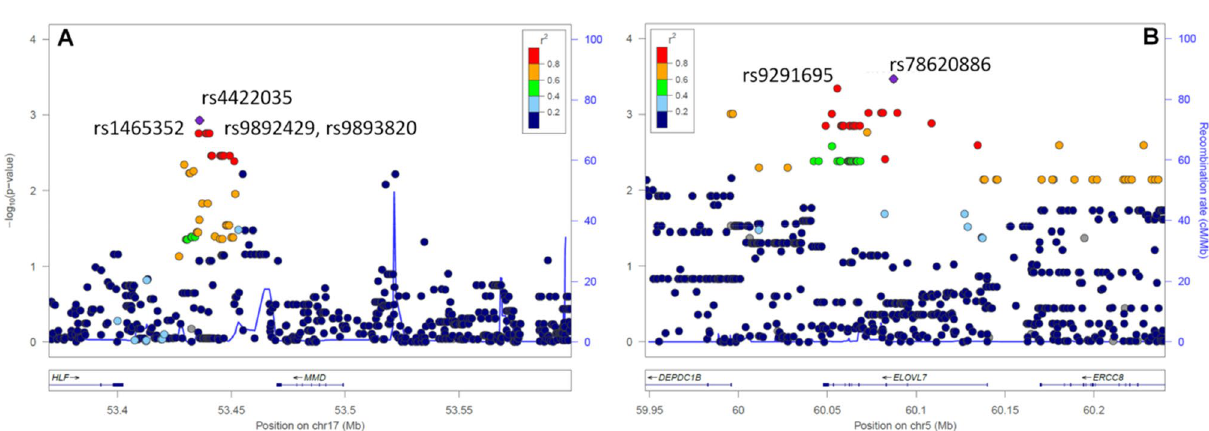
Figure 2. Regional Manhattan plots for MMD and ELOVL7 ± 100 kb gene region. ( A ) MMD ; ( B ) ELOVL7. Regional Manhattan plots were constructed using LocusZoom 24